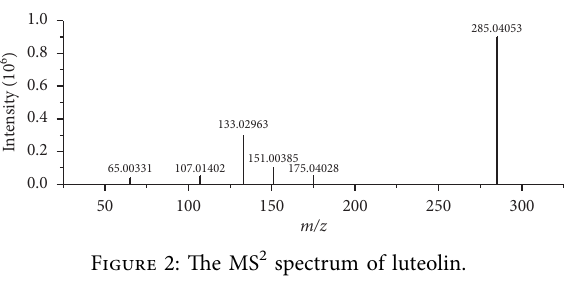
Figure 2: The MS 2 spectrum of luteolin.